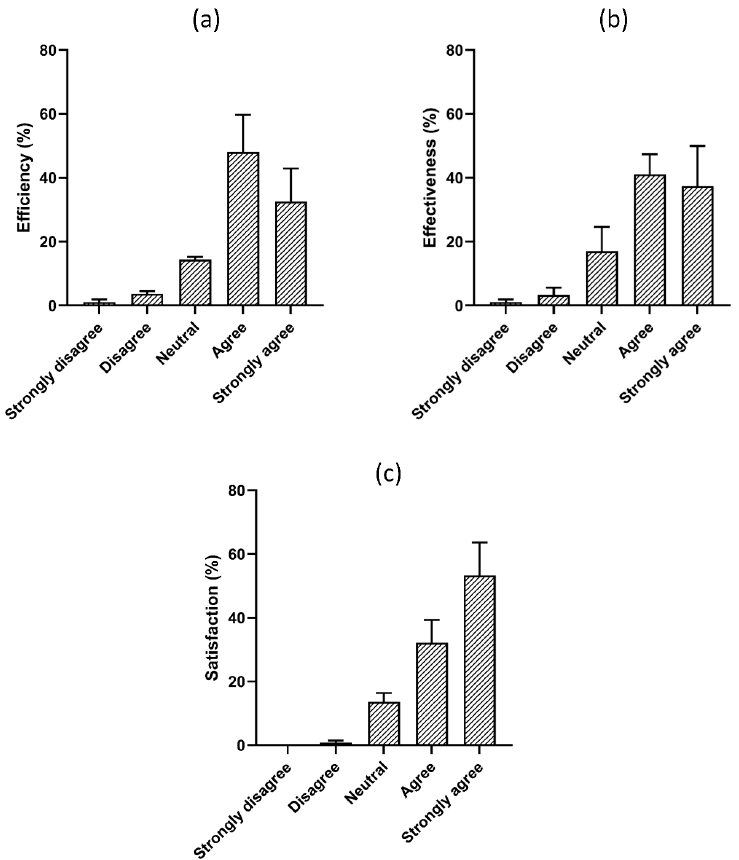
Figure 4. is the graphical presentation of Table 4, where ( a ) shows high values for agreeing towards efficiency for the SSB, ( b ) shows high values for agreeing towards effectiveness for the SSB, and ( c ) shows high values for strongly agreeing towards satisfaction for the SSB.